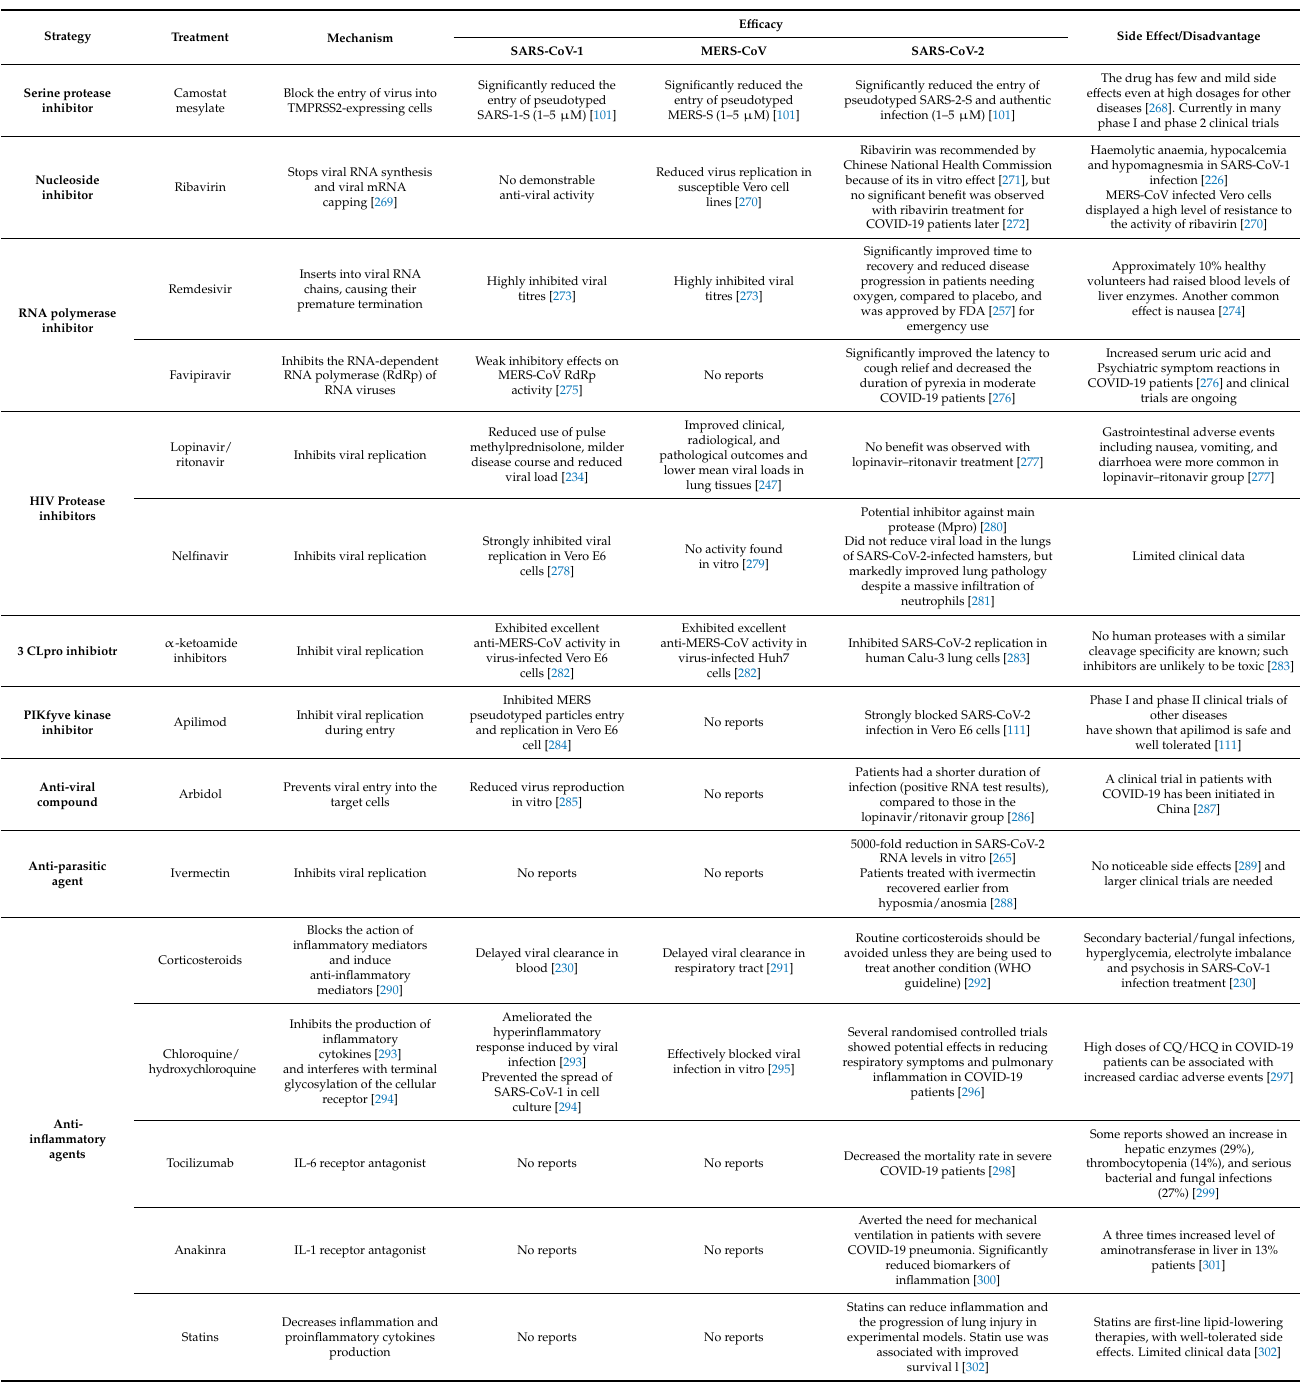
Table 2. A summary of coronavirus therapeutic